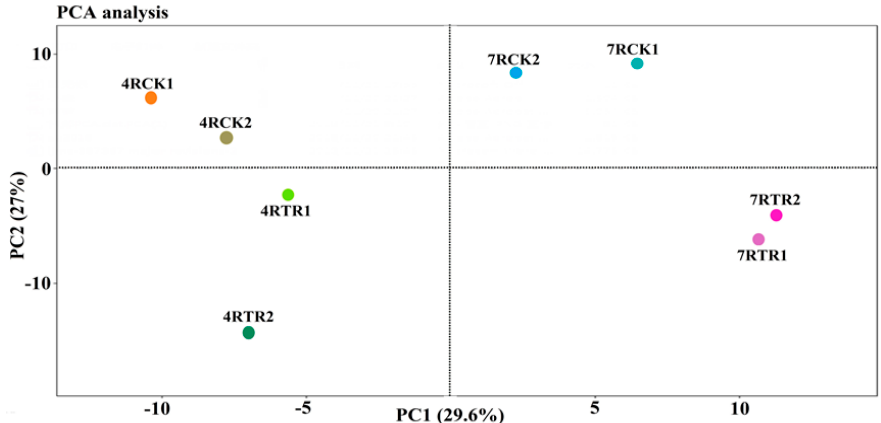
Figure 2. Principle component analysis (PCA) of the proteome from the freezing-stressed and non-stressed winter turnip rape roots. 7RCK and 7RTR denote CK and TR treatments of the R7 variety, respectively. 4RCK and 4RTR denote CK and TR treatments of the R4 variety, respectively.